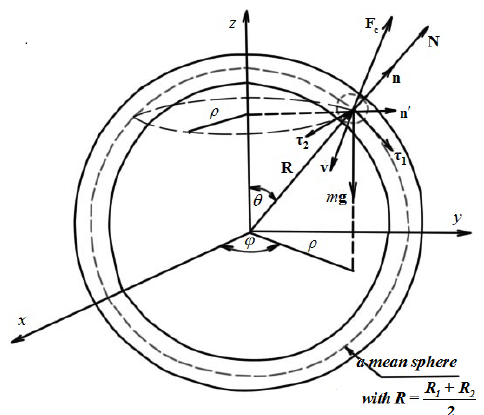
Figure 1. The geometry of the problem. In this figure, concentric circles are used for representation, but it is clear that in the stereometry, they are ellipses. For the simplification of the figure, they are shown as circles. R —a vector of mean radius; n = R —a unit normal vector, where n = n 2 − n 1 ; τ 1 —a unit tangential vector (see the main text of the paper); τ 2 —a unit tangential vector to the instantaneous circle of radius ρ , which is perpendicular to the axis z ; n (cid:48) − a normal unit vector to this circle (it is lying in the plane of ( n − τ 1 ) ; v—a momentary velocity, decomposed into a single instantaneous basis τ 1 and τ 2 ; m g —gravitational force; F c —resistant force directed against velocity vector v and tangential to the surface of the outer sphere. N —reaction force, θ —angle in azimuth, ϕ —polar bearing of the spherical coordinate system, angle α = π − θ